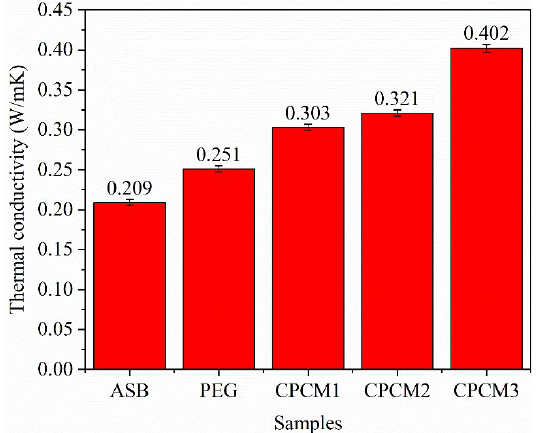
Figure 11. Thermal conductivity of ASB, PEG and PEG/ASB CPCMs.